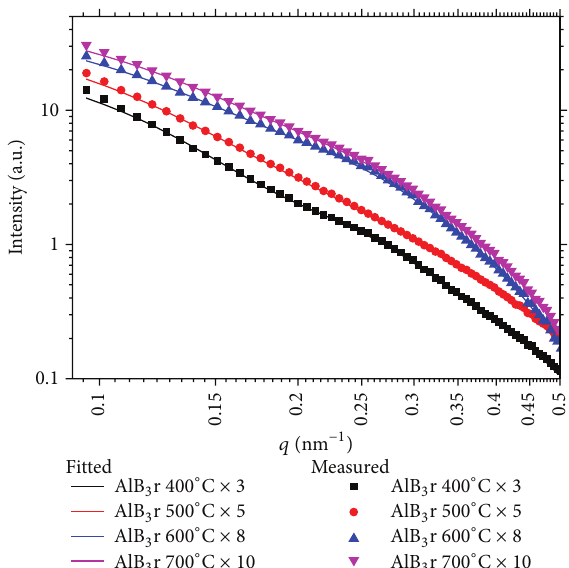
Figure 3: Measured (scatter) and fitted (solid line) SAXS patterns for samples tempered at 400 ∘ C, 500 ∘ C, 600 ∘ C, and 700 ∘ C for about 1 h.